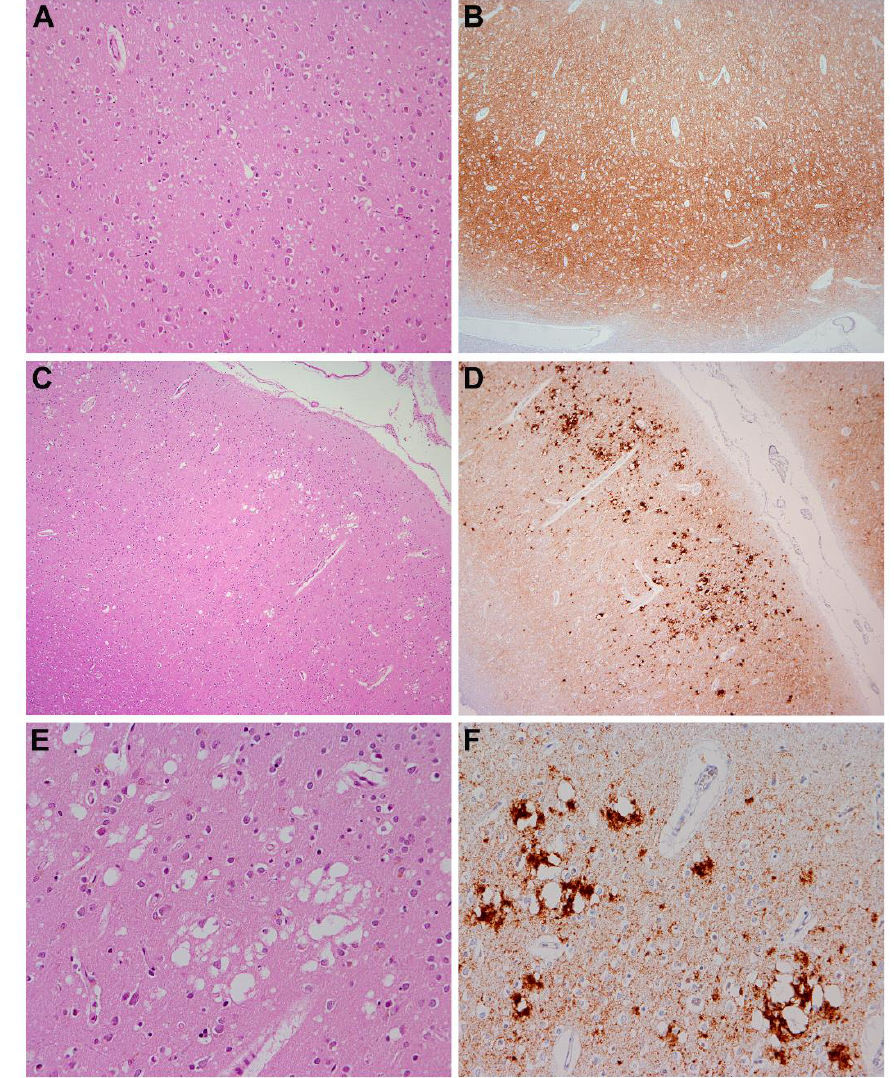
Figure 3. Representative microscopic findings (image kindly provided by Dr. Ellen Gelpi, Medical University of Vienna, Austria). ( A ) Mild spongiform change in cingulate gyrus consisting of small- sized vacuoles throughout the cortex; ( B ) immunohistochemistry showed widespread deposits of the pathological prion protein following a diffuse synaptic pattern; ( C ) in the occipital cortex, there were foci of large confluent vacuoles (enlarged in ( E )); ( D ) immunohistochemistry revealed in these areas (occipital cortex) a patchy-perivacuolar deposition pattern of disease-associated PrP (enlarged in ( F )). Original magnifications: ( A , F ): ×100, ( B – D ): ×40, ( E ): ×200.